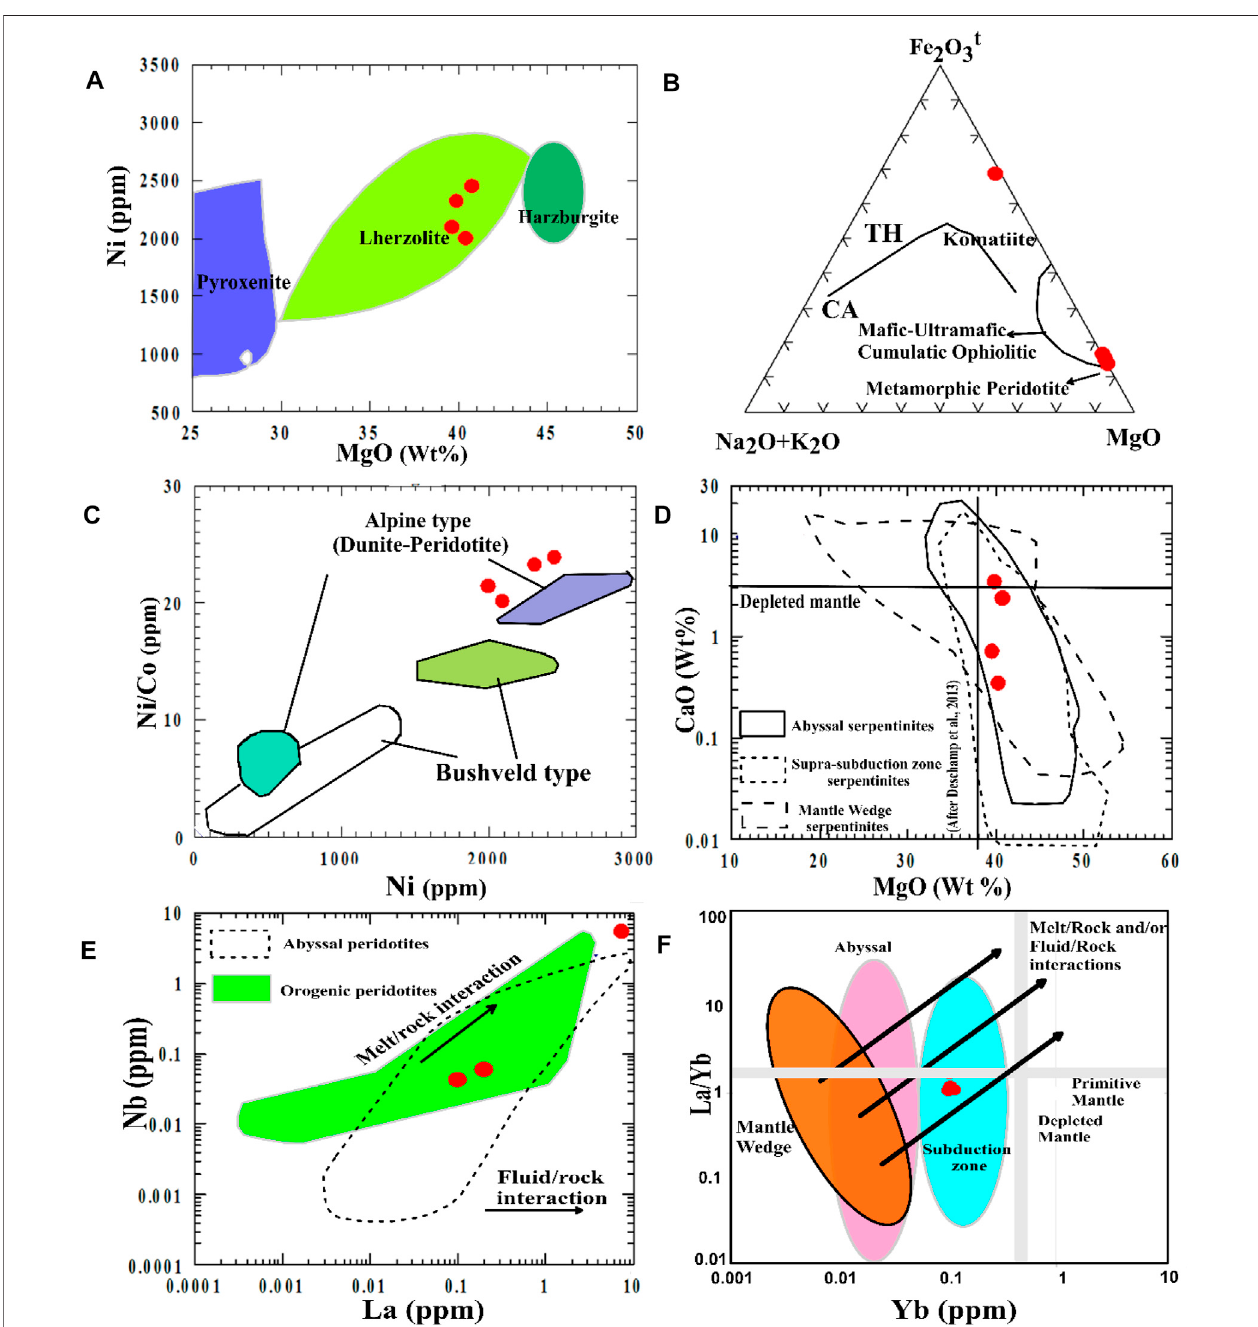
FIGURE 7 | (A) Variation diagrams of Ni versus MgO in the serpentinite rocks (Pfeifer, 1990). (B) Fe 2 O 3t – (Na 2 O + K 2 O) – MgO ternary diagrams after Coleman (1977). (C) Ni/Co versus Ni diagrams incomparison withratios ofalpine-type and Bushveld-layered ultrama fi cs (Gulacar and Delalaye, 1976.( D) CaO versus MgO plots for serpentinite. Mg number lines (Deschamps et al., 2013) and depleted mantle after Workman and Hart (2005). (E) Nb versus La binary diagram after Paulick et al. (2006)andabyssalperidotitesfromPaulicketal.(2006),Deschampsetal.(2013)aswellasorogenicandophioliticperidotitesfromBodinierandGodard(2003). (F) La/Yb ratio versus Yb contents (ppm) for serpentinites after Deschamps et al. (2013).